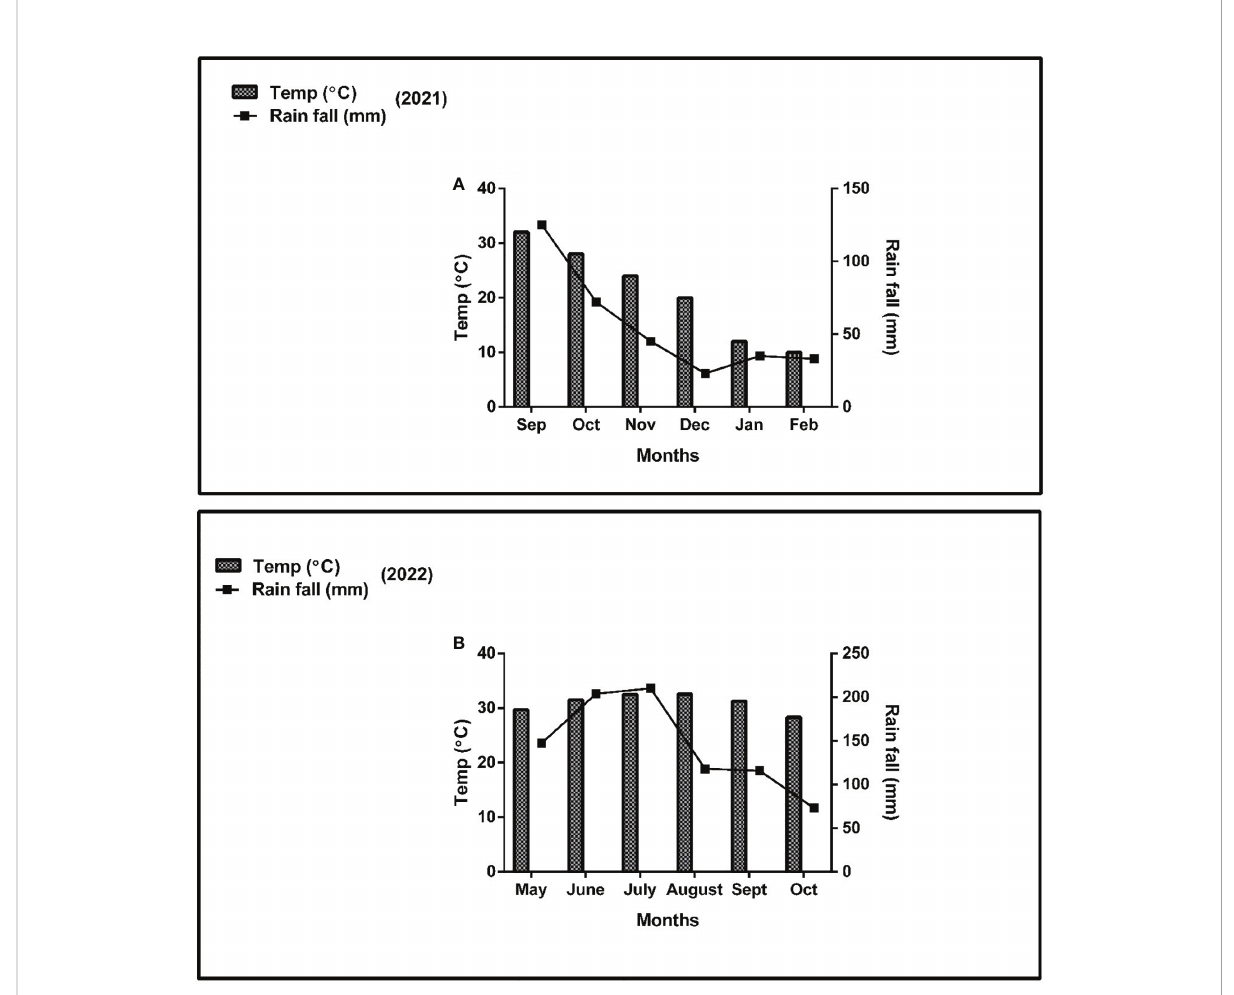
FIGURE 2 Weather forecast (temperature and rainfall) report of the experimental site during the experiment period (A) ; year 2021 and (B) ; year